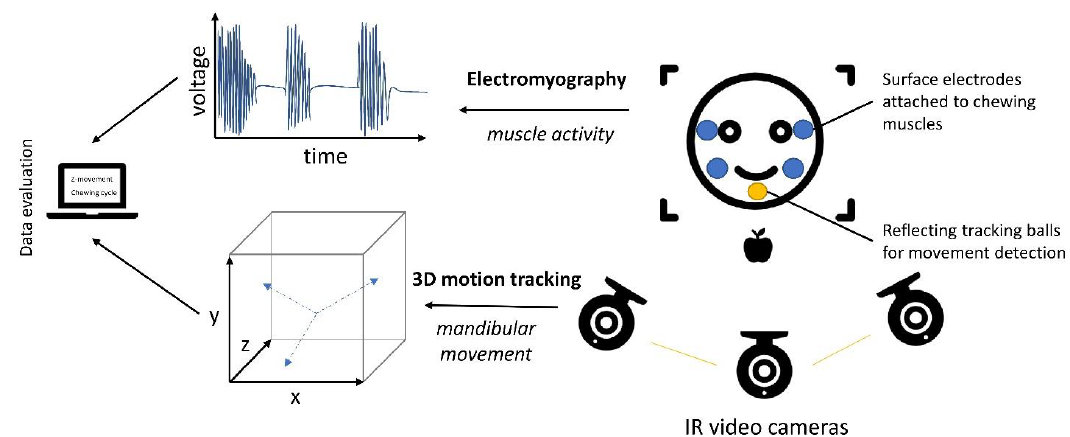
Figure 4. Schematic overview of oral processing analysis using electromyography and three-dimensional (3D) motion tracking using infrared video cameras.